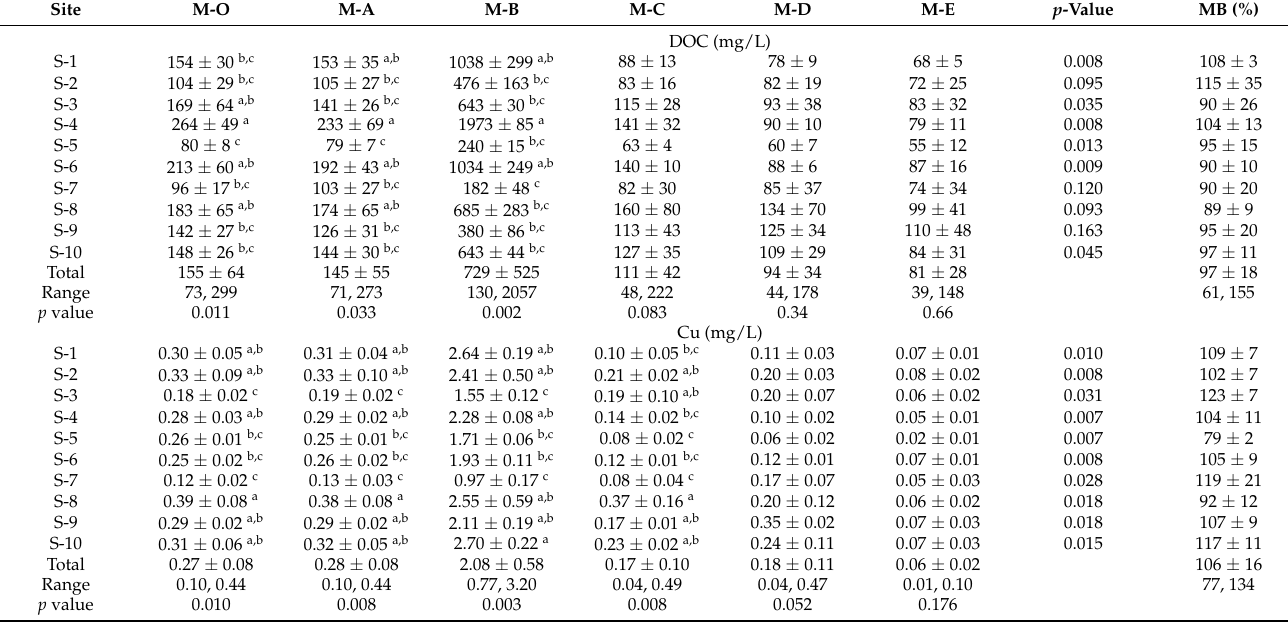
Table 3. Cu and DOC mean and standard deviation concentrations of bulk and size-fractioned AEOM solutions for each